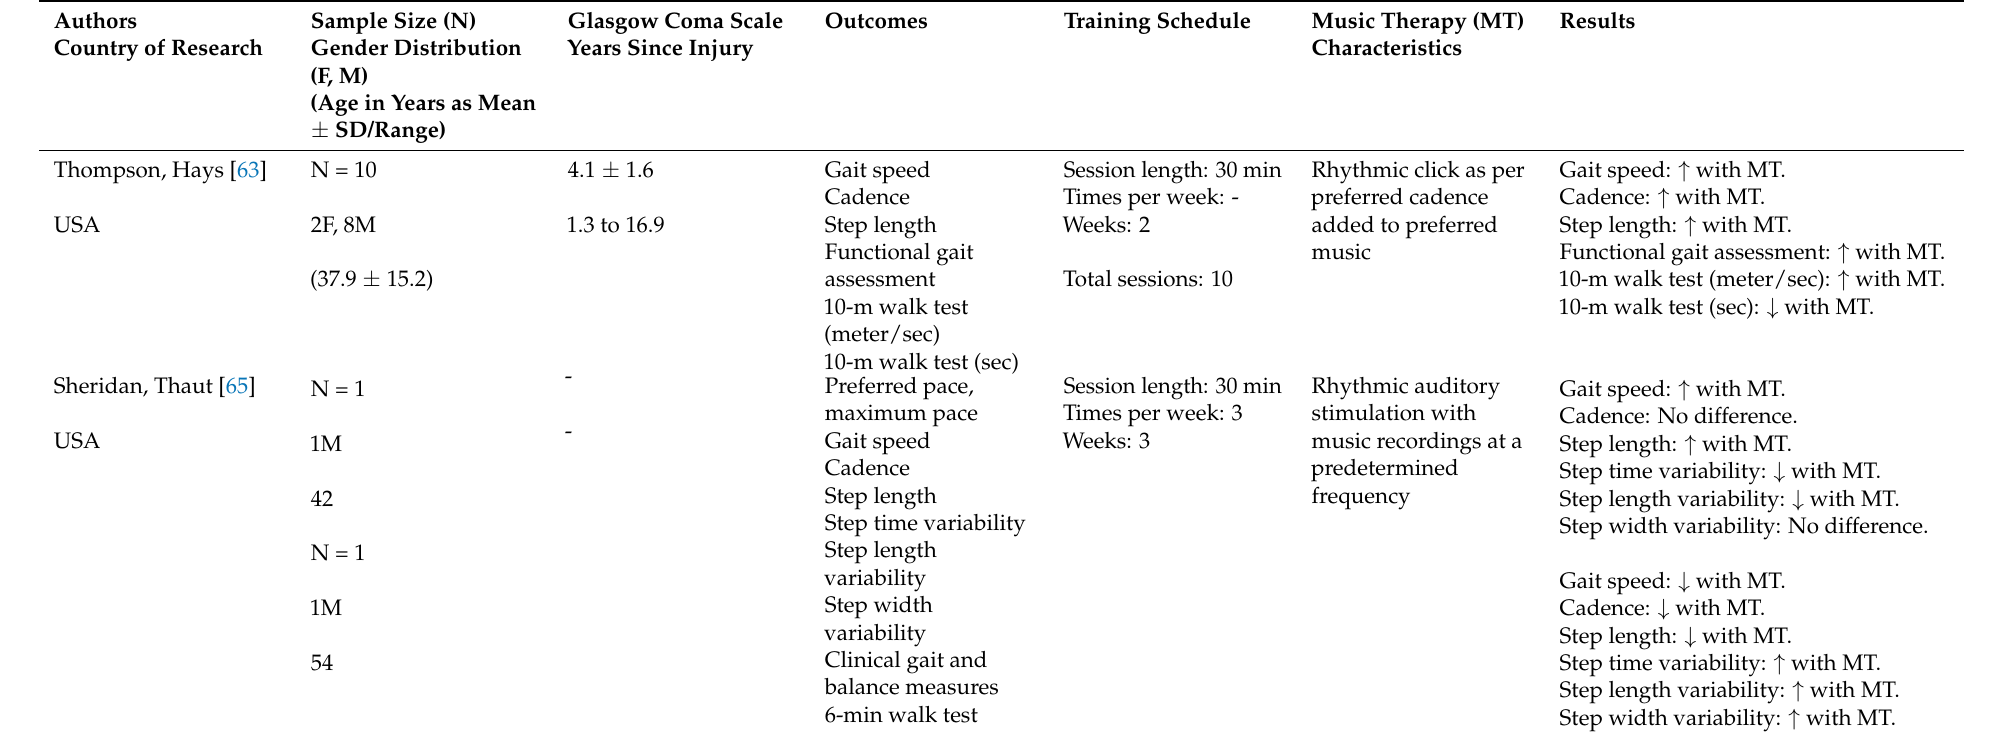
Table 1. Details of studies evaluating individuals with traumatic brain